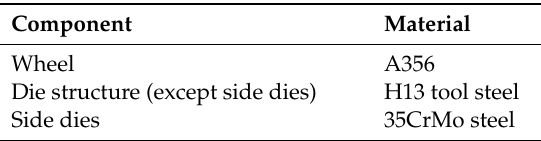
Table 1. Components and their